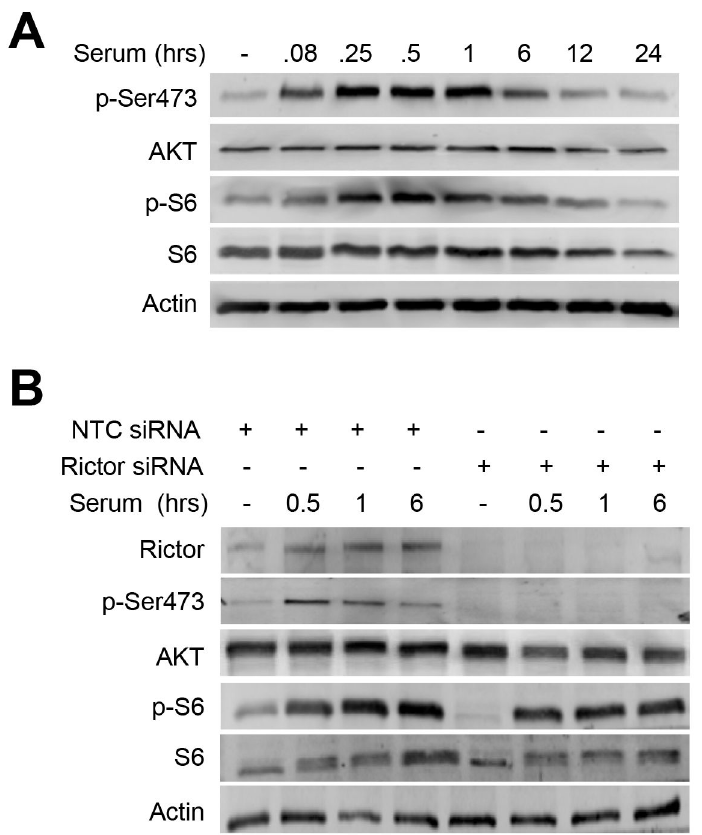
Figure 3. Temporal profiling of mTORC2 activity in malignant bladder cancer cells shows an early response to serum stimulation. A , serum stimulation in J82 cells shows high levels of mTORC2 (p-Ser473) activity by 5 min that persists through 6 h. B , rictor gene-silencing using pooled siRNA dramatically reduces detectable rictor protein and ablates p-Ser473 relative to that observed in cells transfected with NTC siRNA. No effect on mTORC1 signaling (p-S6) was detected. doi: